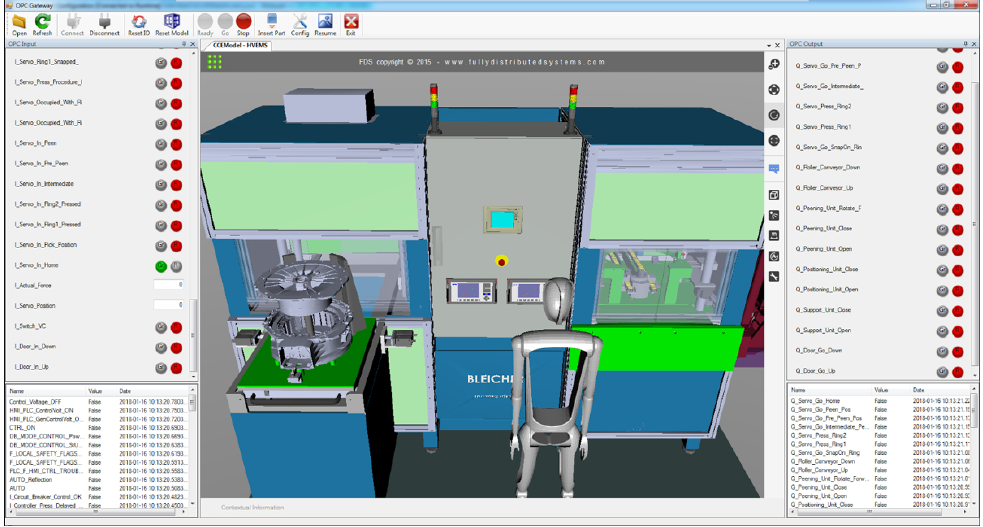
Figure 9. Virtual commissioning application interface (vueOne OPC Gateway).